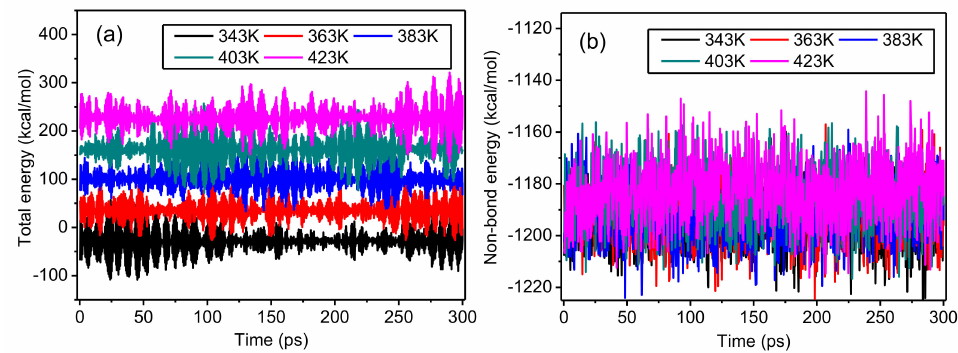
Figure 5. Changes of ( a ) total energy and ( b ) non-bond energy during the simulations at different temperatures.